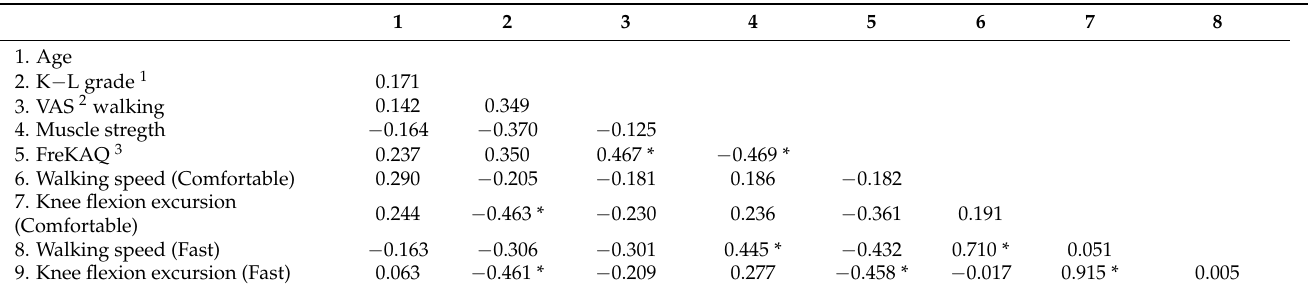
Table 4. Correlation matrix between all